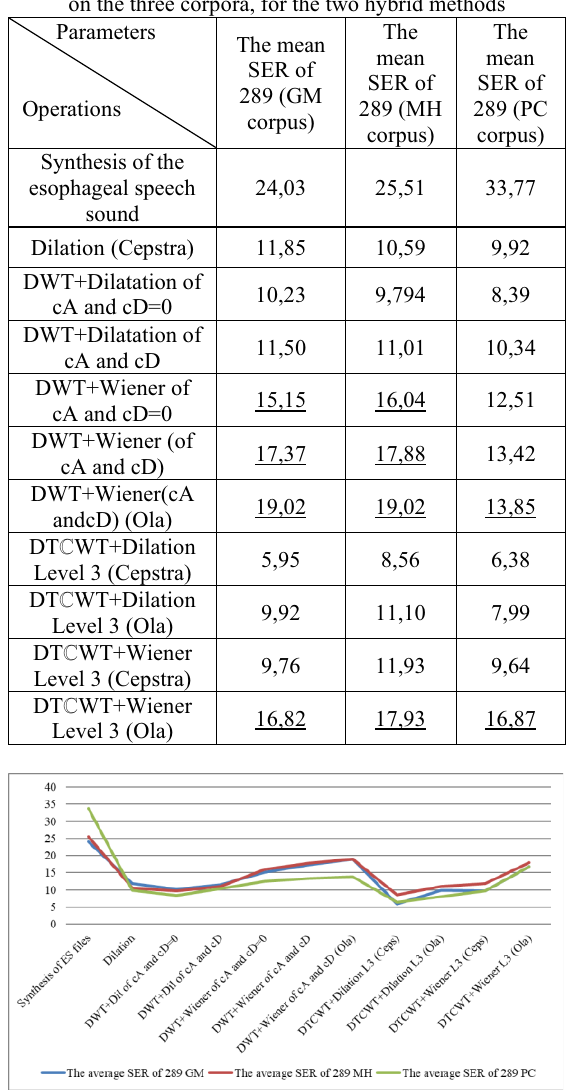
Fig. 7. The average of SER curves of the two hybrid methods for the 289 ES sound files obtained from the PC, MH, and GM